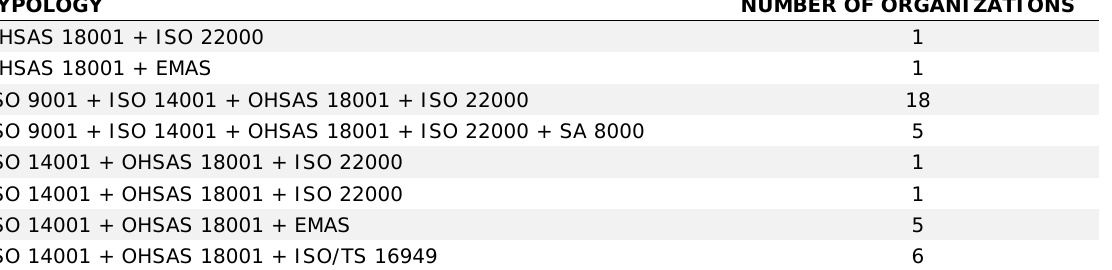
Figure 8. Evolution of the integrated OHSMSs- Breakdown by Typology (Portugal).